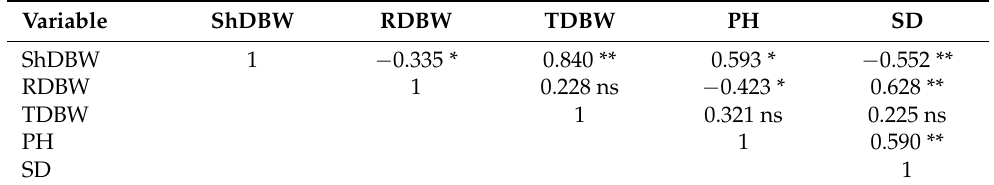
Table 3. Correlation among growth variables of lulo plants ( Solanum quitoense Lam.) grown in different peatmoss/compost percentages ( v / v ) under greenhouse conditions for two months. Variable ShDBW RDBW TDBW PH ShDBW